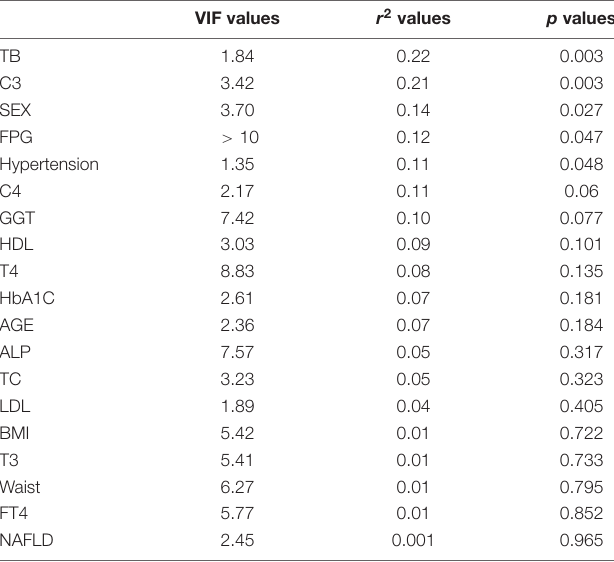
TABLE 2 | Correlation coefficient between clinical factors and gut microbial. VIF values r 2 values p